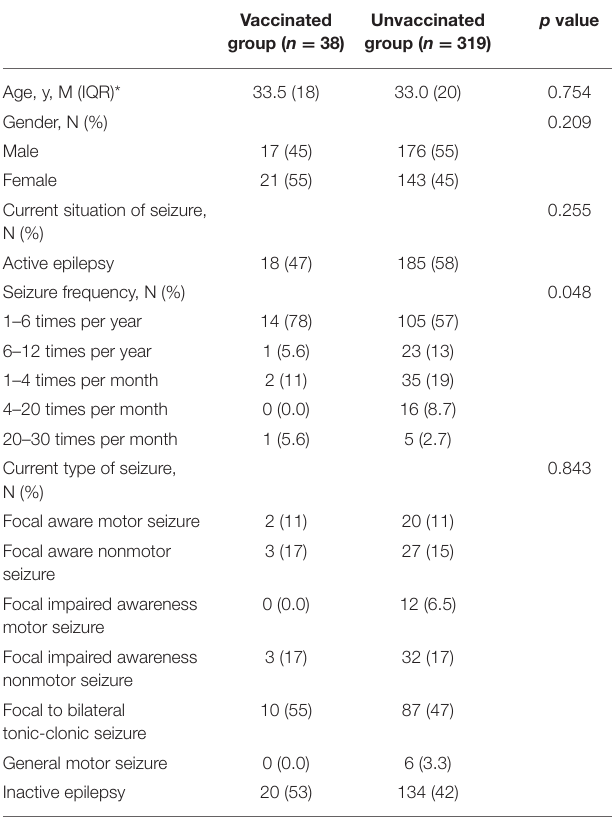
TABLE 1 | Demographic information of people with epilepsy in the survey. Vaccinated group ( n =